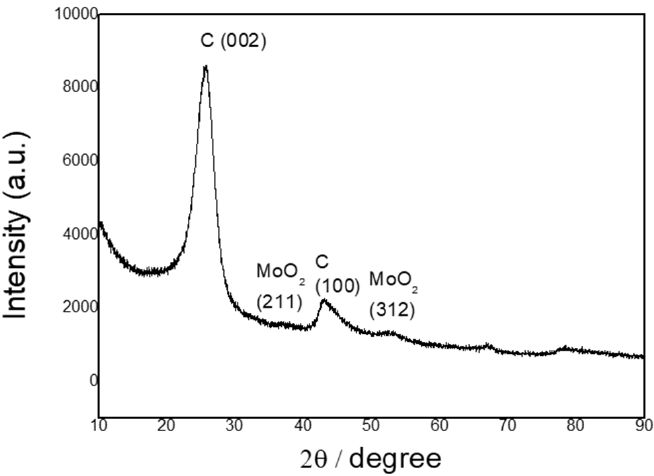
Figure 2. X-ray diffraction (XRD) pattern of 10% Mo/CNT catalyst.